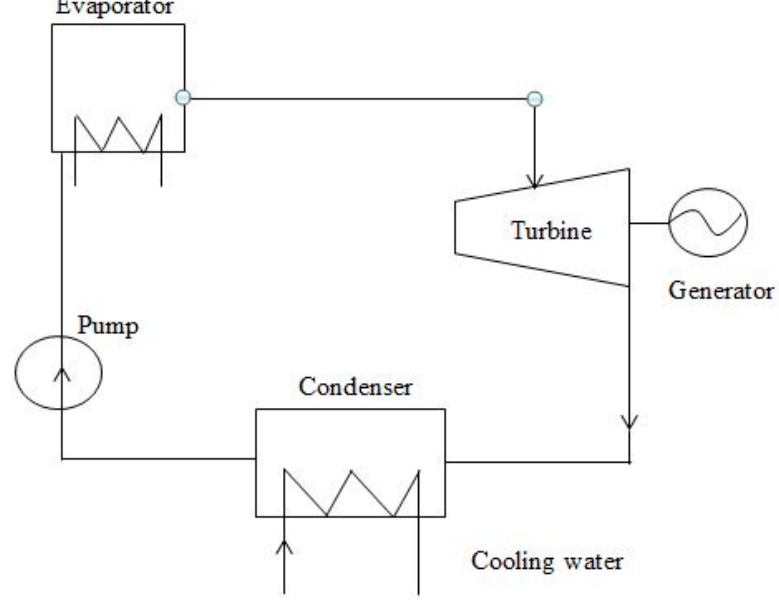
Figure 1. Schematic diagram of a basic Organic Rankine Cycle (ORC) system.